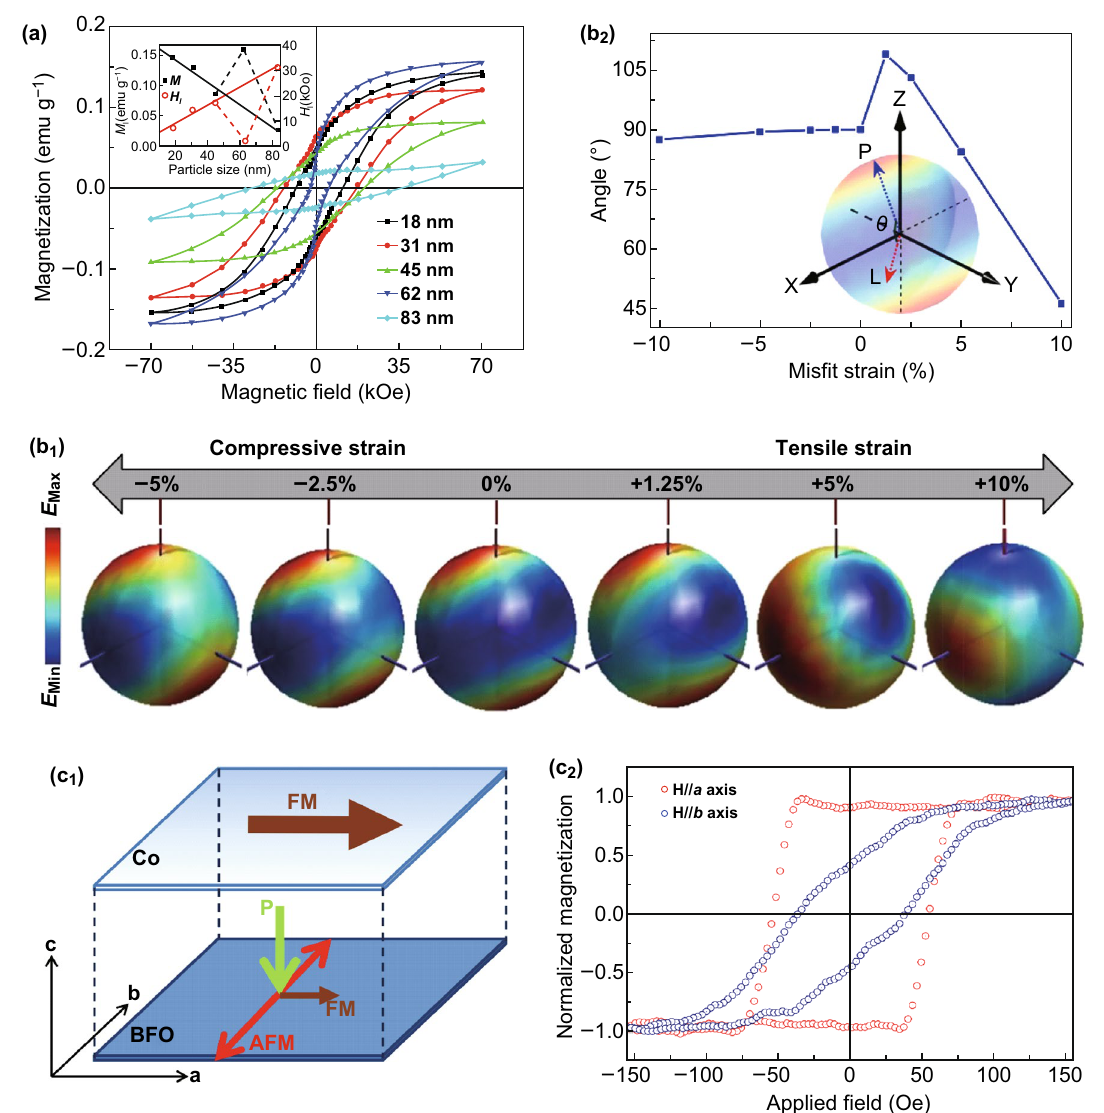
Fig. 4 Magnetic properties of BFO nanomaterials. a Size effect for magnetic response of BFO nanostructure. Adapted with permission from Ref. [96]. b 1 Three‑dimensional illustration of the change of the magnetic energy landscape with different strain states. b 2 The angle of antifer‑ romagnetic axis and the polarization with the strain. Adapted with permission from Ref. [28]. c Single‑domain behavior in both magnetism and ferroelectricity for BFO thin film. c 1 Schematic diagram of the magnetization and ferroelectric polarization axes in a Co/BFO heterostructure. c 2 Magnetic hysteresis loop of the heterostructure (red and blue circles represent the magnetic field along a axis and b axis, respectively). Adapted with permission from Ref. [29]. (Color figure